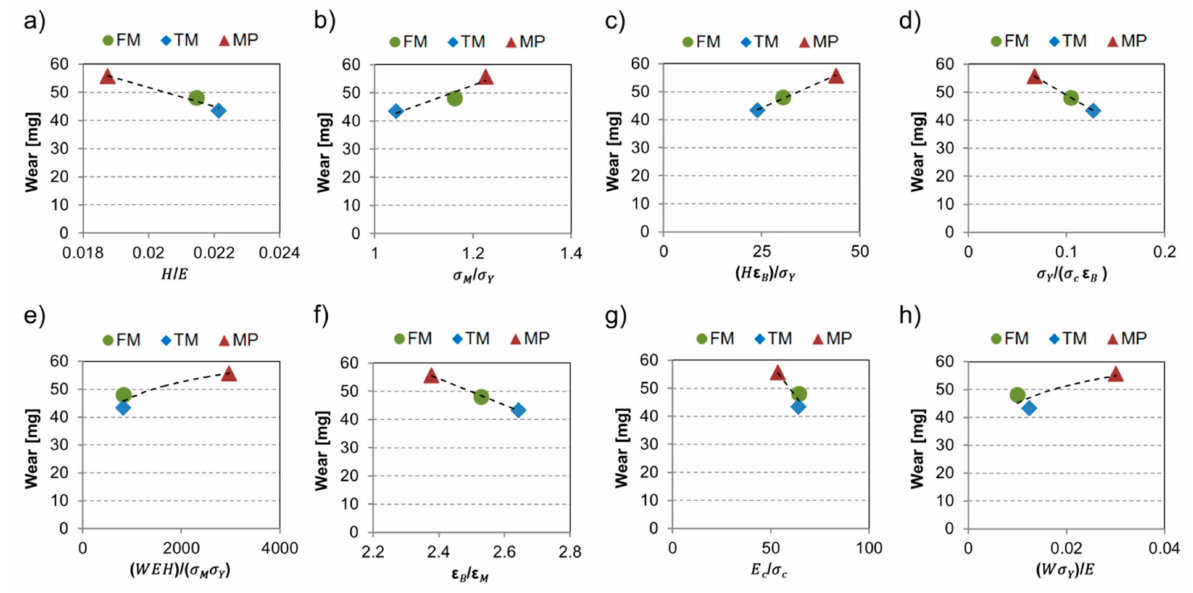
Figure 9. Wear of the most severe test condition (P80, 24.2 N) in the function of dimensionless features: ( a ) H